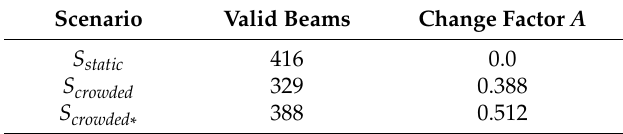
Table 2. Medium change per laser beam in the static scenarios relative to S static